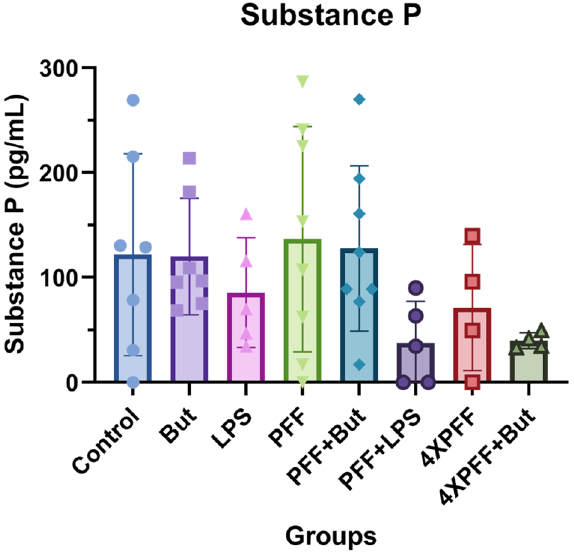
Figure 7. Substance P ELISA quantification of Day 21 spent medium demonstrates no significant differences between groups. N = 4–7. Error bars =